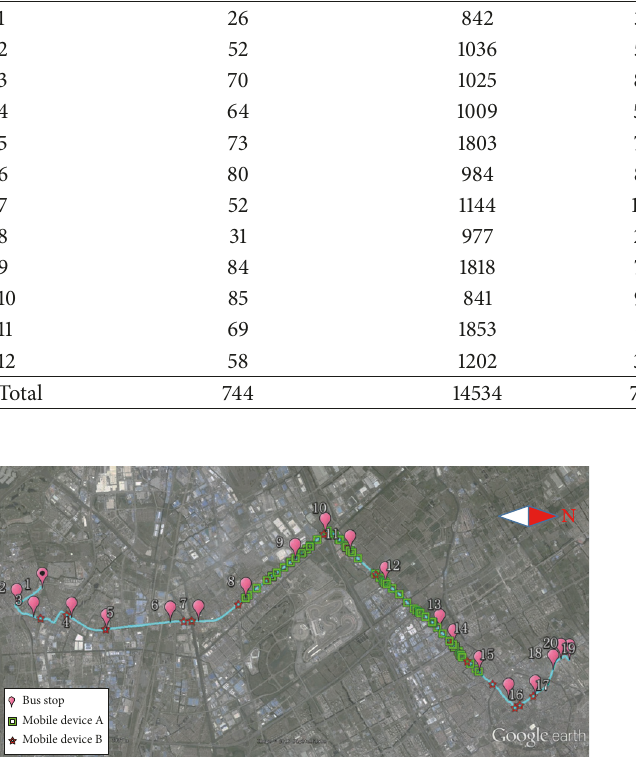
Figure 1: Illustration of Wi-Fi signals on the route